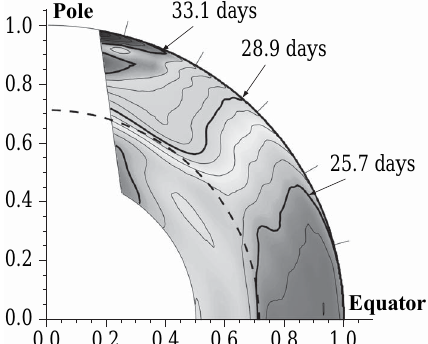
Figure 2. A meridional cut through the solar interior, showing the rotation rate deduced by solar seismology techniques. Rotation times are indicated on three thick curves. There are shear layers at the solar surface and at the tachocline (after Schou et al.,